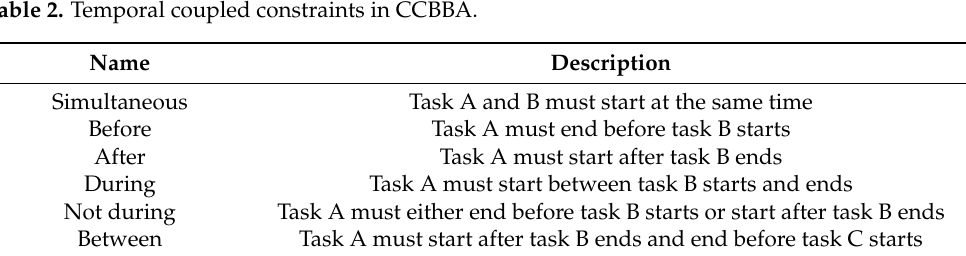
Table 2. Temporal coupled constraints in